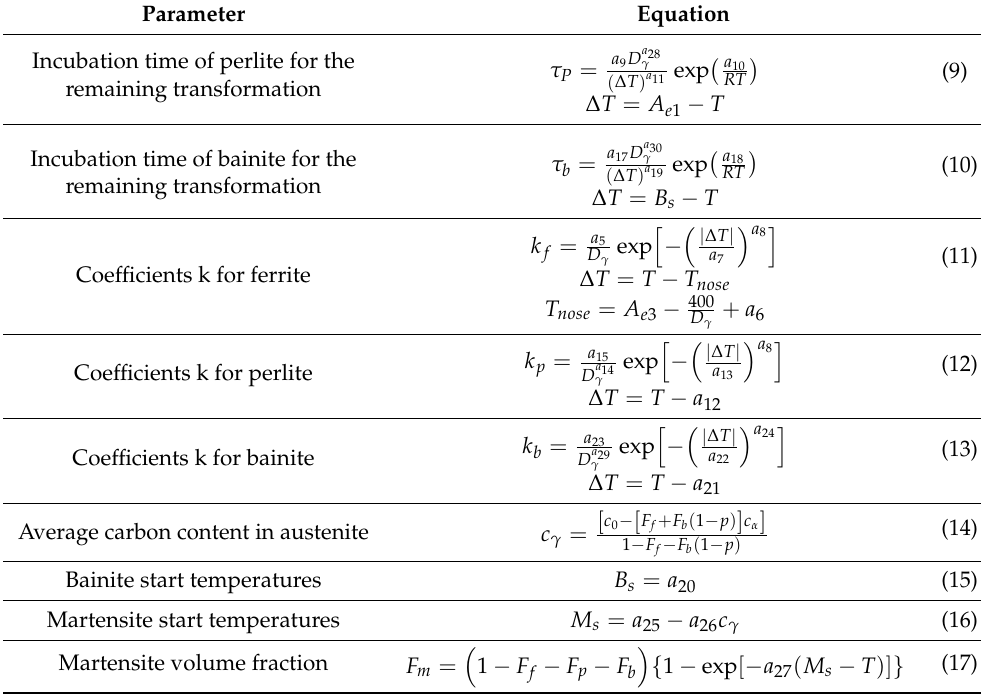
Table 2. Equations in the phase transformation